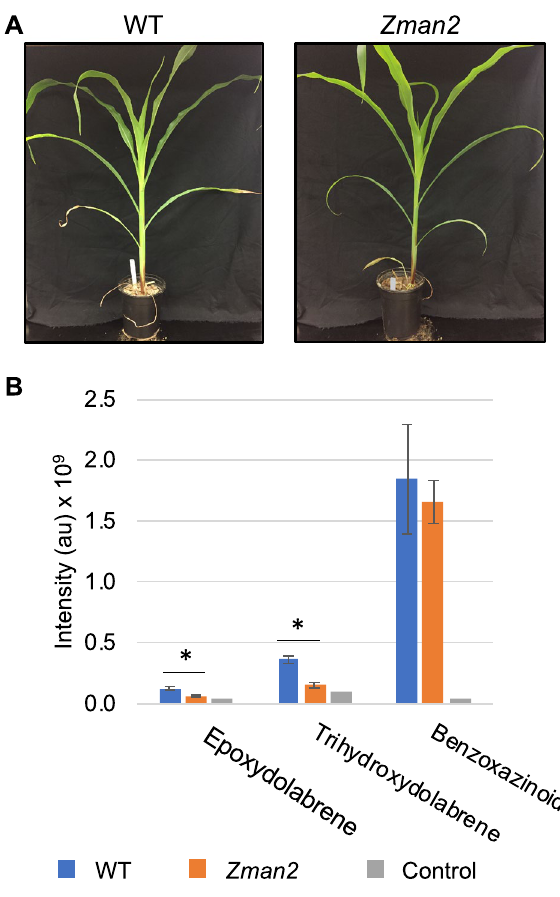
Figure 2. Phenotype and metabolite abundance in maize Zman2 mutants and WT plants. ( A ) Representative images of Zman2 mutant plants and the corresponding WT sibling used in this study. ( B ) Average intensity of metabolites in maize root exudate samples using positive mode LC–MS/MS analysis. Peak area given for epoxydolabrene [M + H], trihydroxydolabrene [M + H-H2O], and benzoxazinoids, with the last based on detection of metabolites containing BOA (1,3-benzoxazol-2-one (BOA) [M + H]). * represents significant difference between two sample types, p ≤ 0.05. Two-tailed t-tests were used for benzoxazinoids; one-tailed t-tests were used for dolabralexins, since they are predicted to be enriched in WT and deficient in Zman2. Error bars represent standard error. n = 5 (WT, Zman2 ); Control represents one extraction of nutrient water, and demonstrates LC–MS/MS